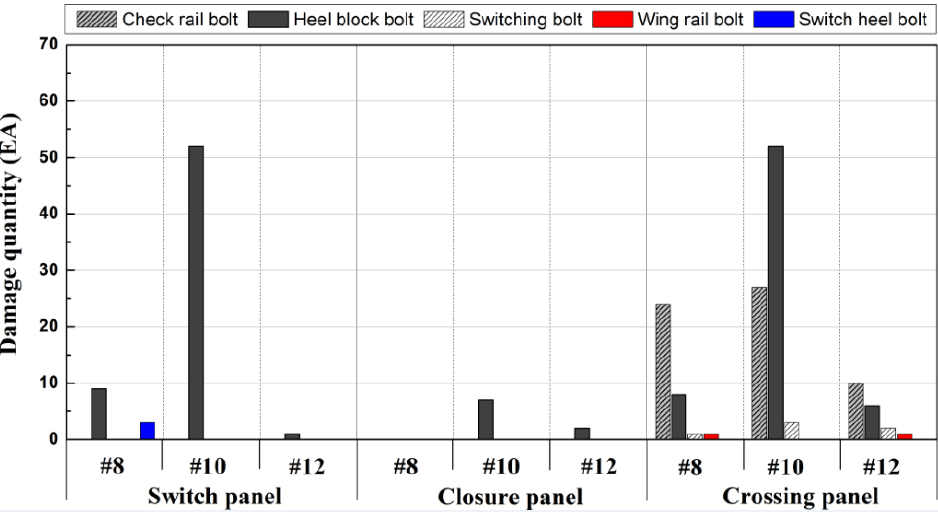
Figure 15. Damage status of